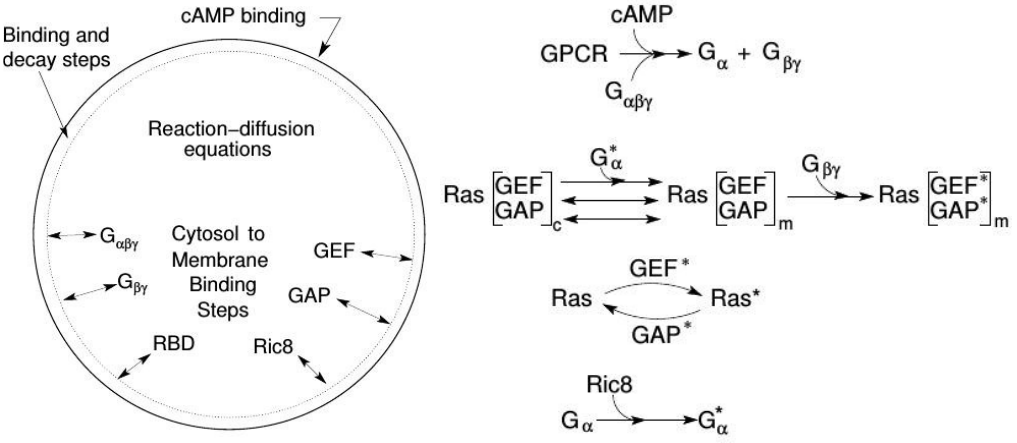
Figure 19. A schematic of the major processes in the model ( left ), and the primary steps in the network ( right ). From Cheng and Othmer